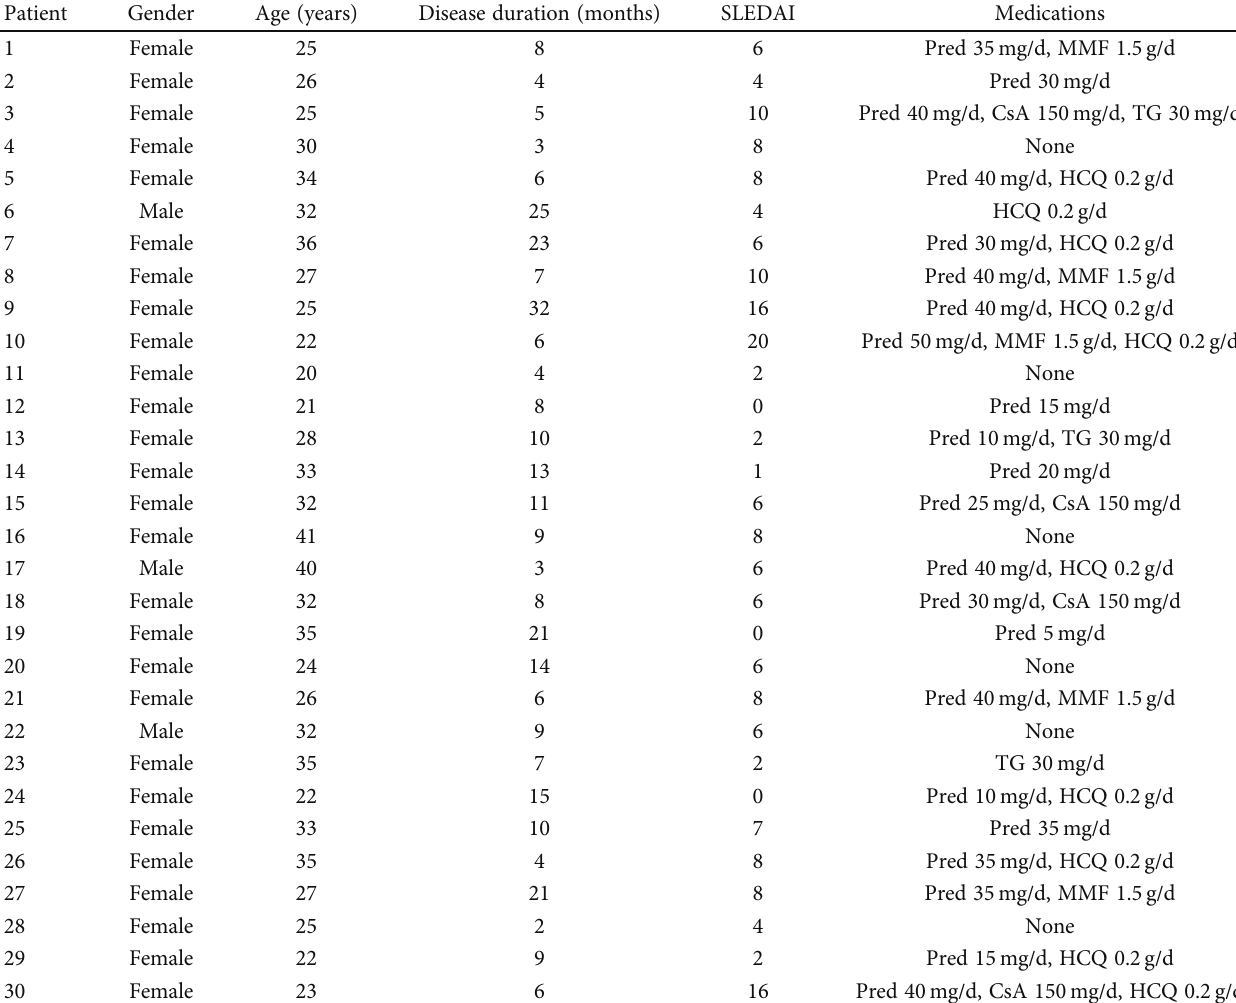
Table 1: Pro fi les of SLE